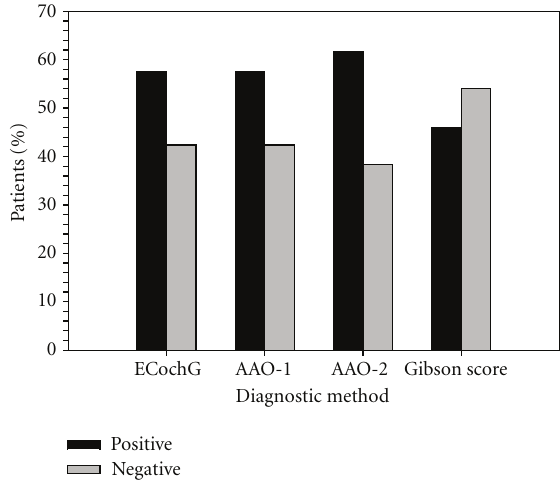
Figure 4: Percentage of participants identified as “positive” and “negative,” respectively, using di ff erent diagnostic methods, includ- ing ECochG method, AAO-HNS CHE criteria with only “definite” being classified as “positive” (AAO-1), AAO-HNS CHE criteria with both “definite” and “probable” being classified as “positive” (AAO- 2), and Gibson score with 7 as the cuto ff